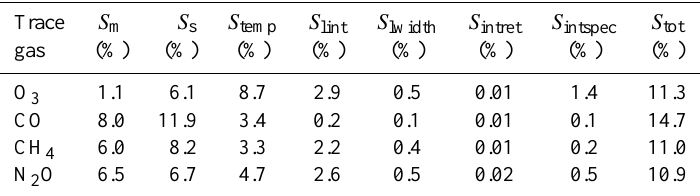
Table 2. Error components for each retrieved trace gas total column. S tot is determined from Eq. (3). Errors are based on a single spectrum on 4 April 2009; these errors are typical for other dates and decrease slightly in the winter and increase slightly in the summer as a result of decreased/increased H 2 O emission (for